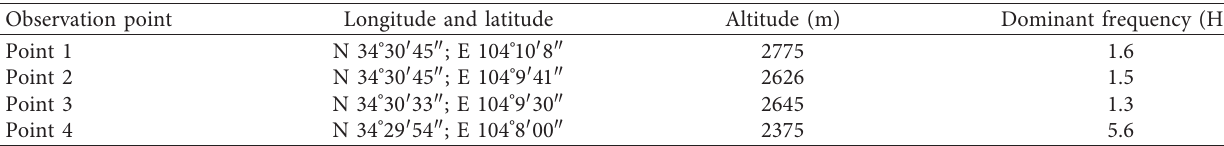
Figure 15: Displacement-time history curve under different seismic excitations: (a) under Minxian seismic excitation and (b) under Tianshui seismic excitation. Table 4: The site-predominant frequencies of different observation